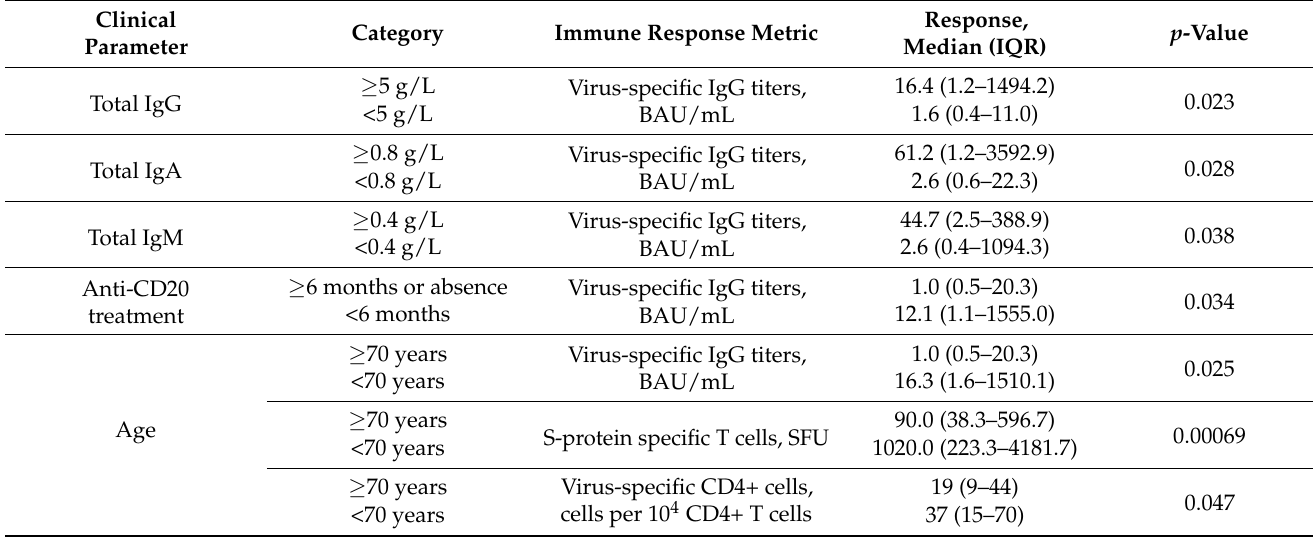
Table 3. The impact of clinical parameters on the postvaccinial immune response